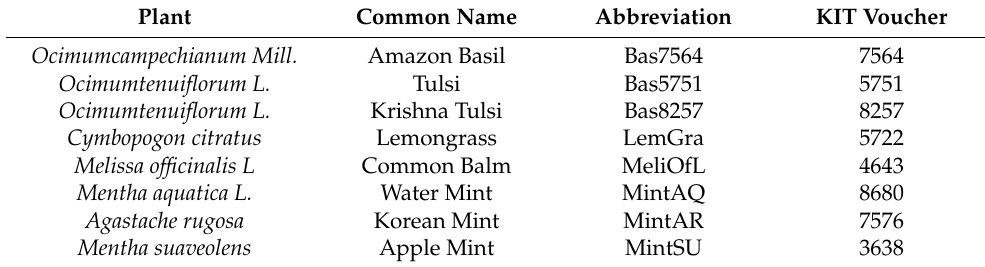
Table 1. Accessions used in this study. The voucher number gives the code, under which the plants are available in the botanical garden of the KIT. The abbreviations used in the text are also